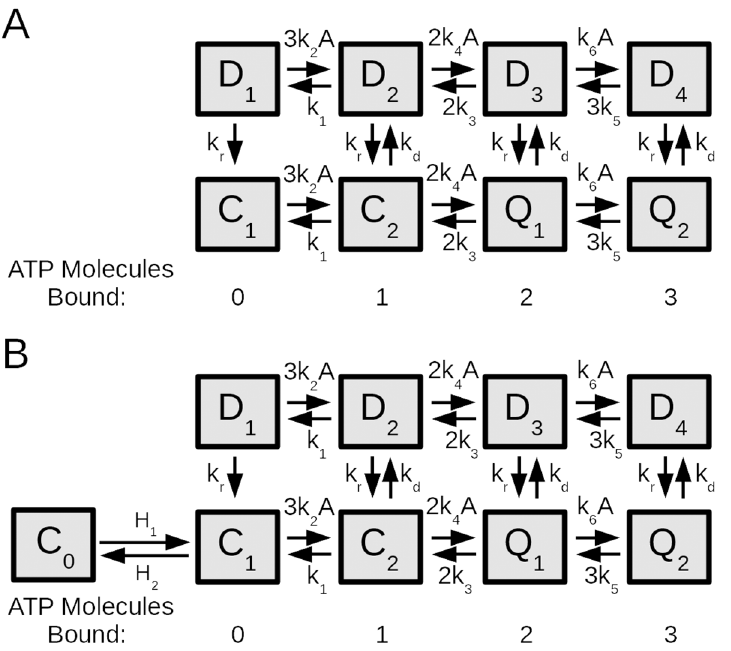
Fig 2. Generic desensitization schemesof ligand-gated ion channels with three agonist binding sites. (A) A diagram of the underlying orthosteric (ATP) gating scheme based on previously developed P2XR models, consisting of closed ( C 1 , C 2 ), open ( Q 1 , Q 2 ) and desensitized ( D 1 , D 2, D 3 , D 4 ) states, each representing the fraction of receptors at a given state. The forward (backward) rates of agonist binding (unbiding)are representedby k 2 , k 4 , k 6 ( k 1 , k 3 , k 5 ), where A denotesthe concentration of agonist, and the desensitization (recovery) rates are denoted k d ( k r ). (B) A diagramof the gating scheme in A augmentedby a deeplyinactivatedstate C 0 and two additionaltransition rates H 1 , H 2